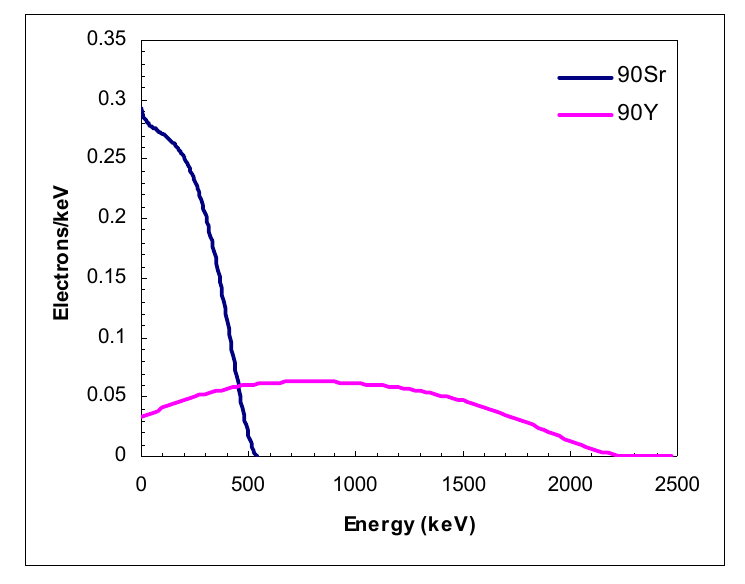
Figure 1. Graph of relative intensity for electrons emitted by 90 Sr and 90